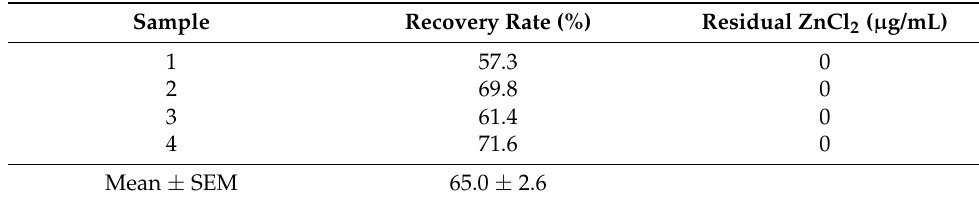
Table 1. Recovery rate of silk fibroin after dissolution in ZnCl 2 (56% w / w ) and desalting using gel filtration.